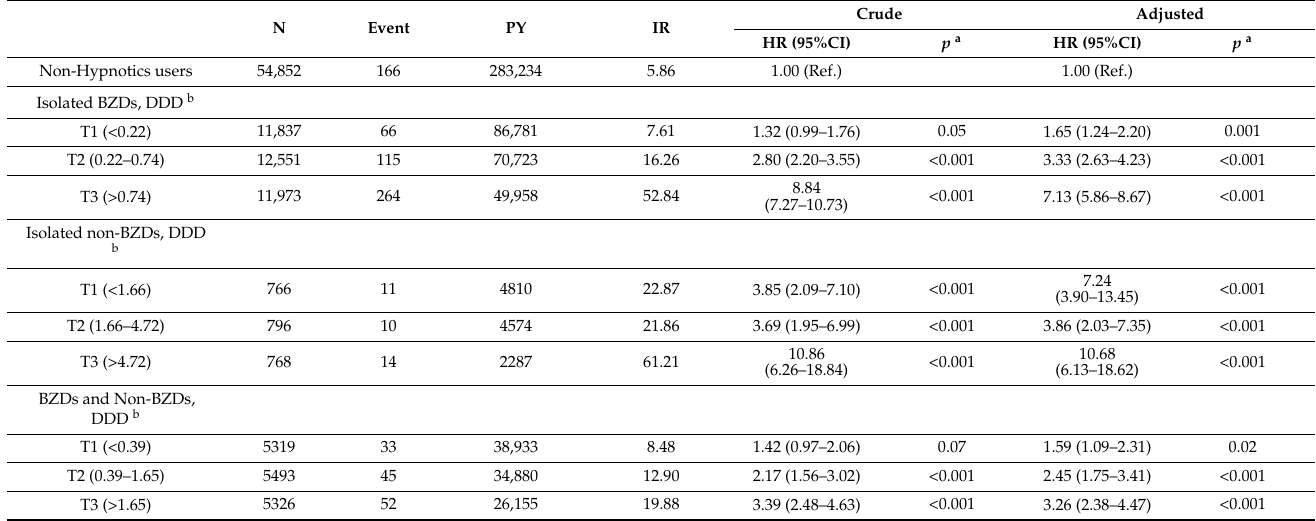
Table 3. Estimated dose–response associations between prescribed use of hypnotics and risk of new-onset atrial